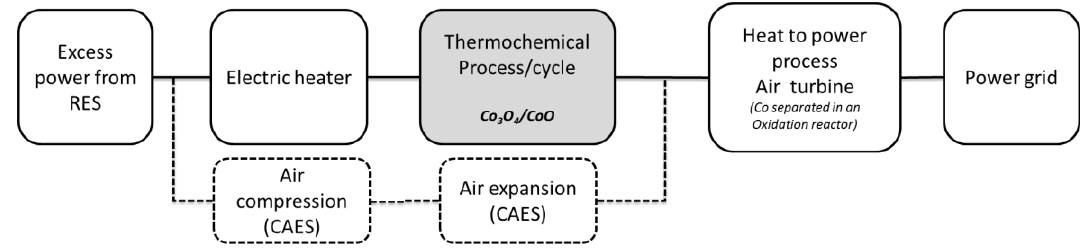
Figure 8. PtH / TCTES system developed by Wu et al. [245]. Figure 8. PtH/TCTES system developed by Wu et al. [246].